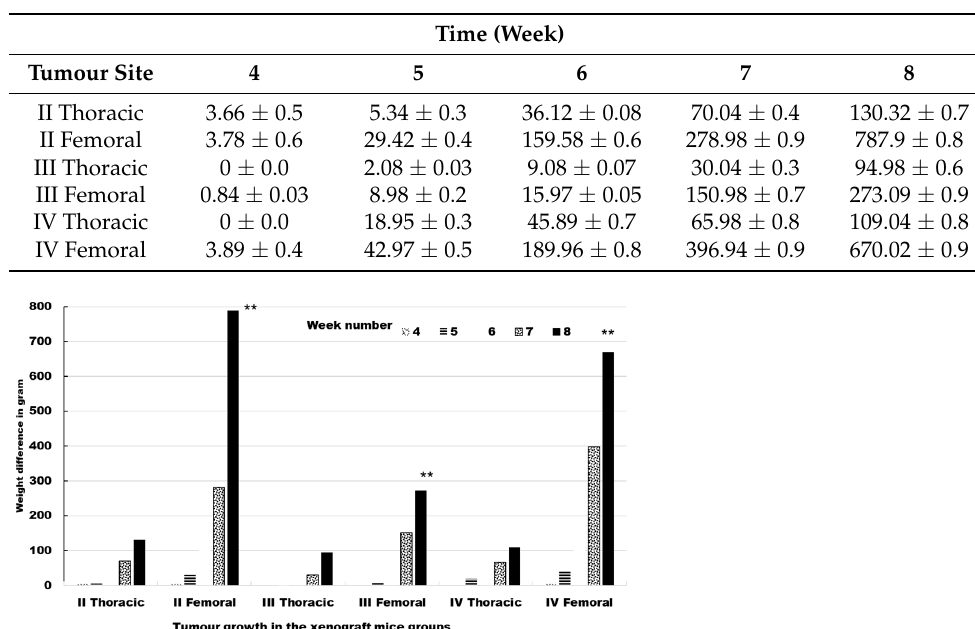
Table 2. TNF- α and IL-6 levels of tumor tissue in the control and groups II, III, IV, and V. Experiments were repeated three times and data are presented as mean ± SD. * p < 0.05; ** p < 0.01; and *** p < 0.001 unpaired Student t